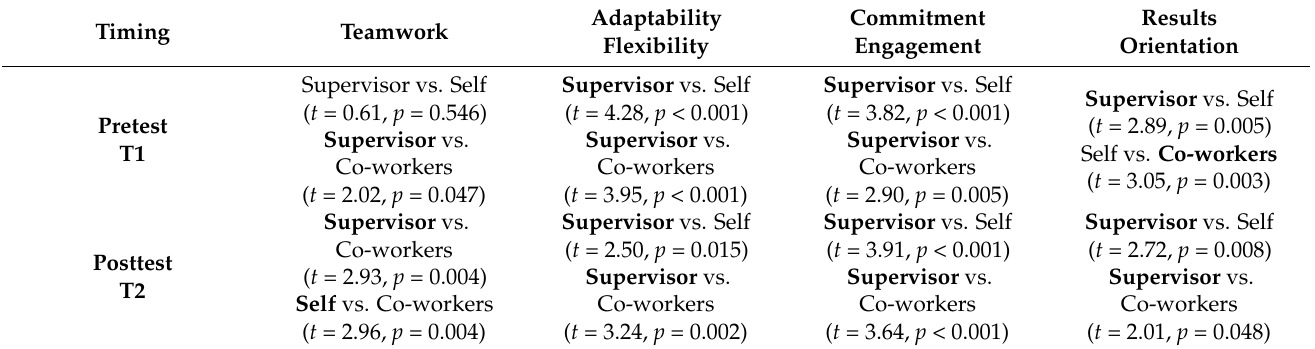
Table 5. Simple effects results of the three sources by pretest–post-test for each